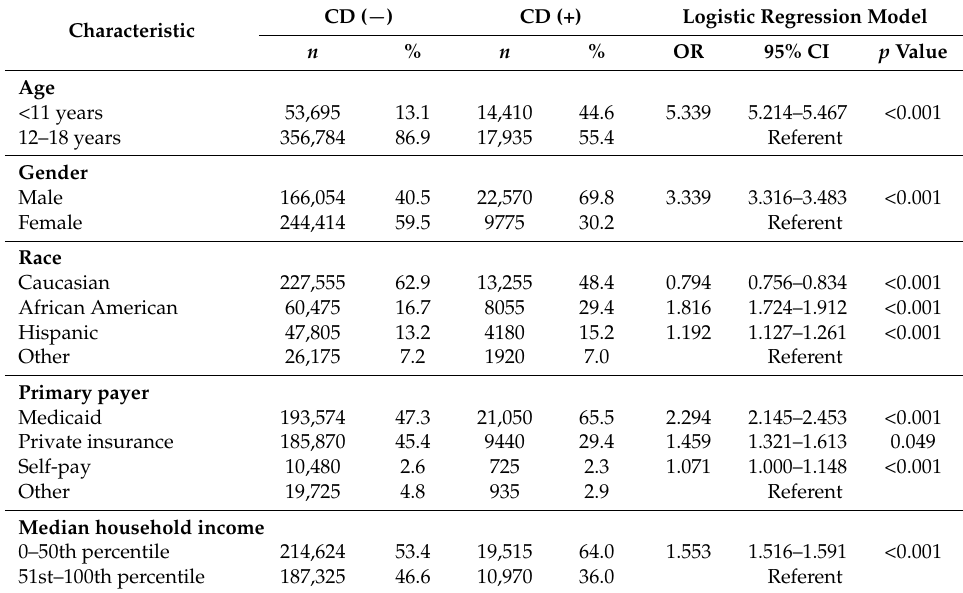
Table 1. Demographic predictors of hospitalized patients with conduct